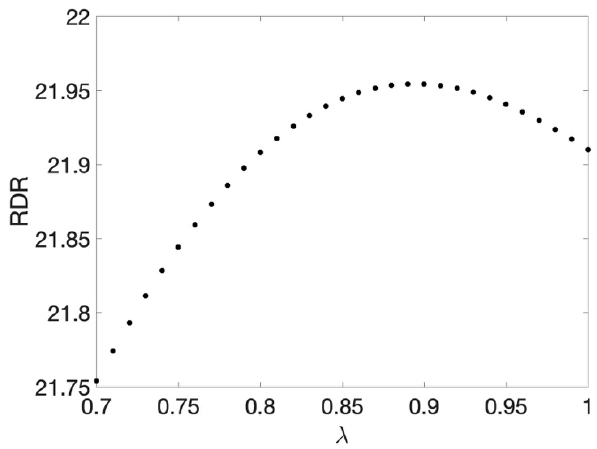
Figure 24. RDR vs. 𝜆 for an unstable time delay system. Figure 24. RDR vs. λ for an unstable time delay system. The closed-loop simulation results for reference tracking are indicated in Figure